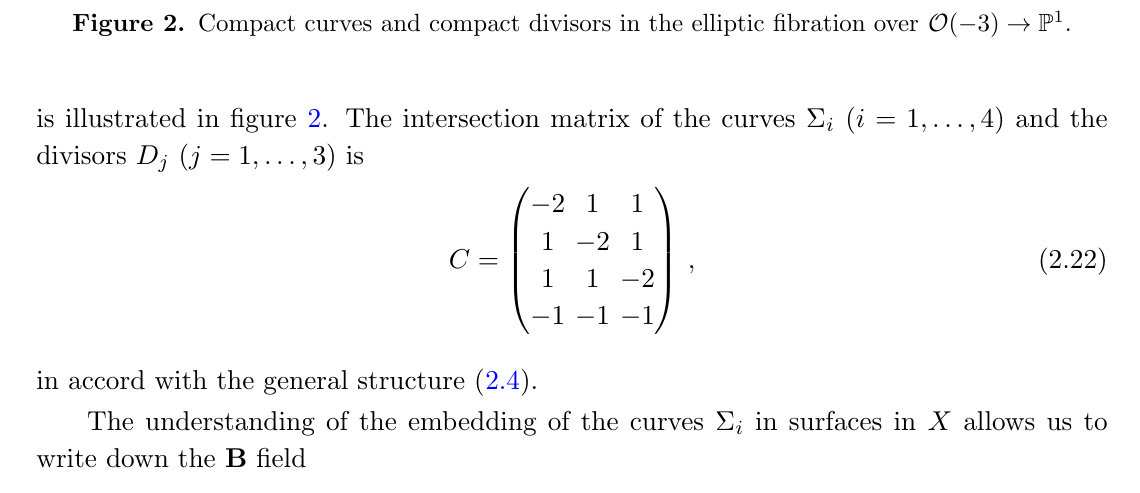
Figure 2. Compact curves and compact divisors in the elliptic (cid:12)bration over O ( (cid:0) 3) ! P 1 .